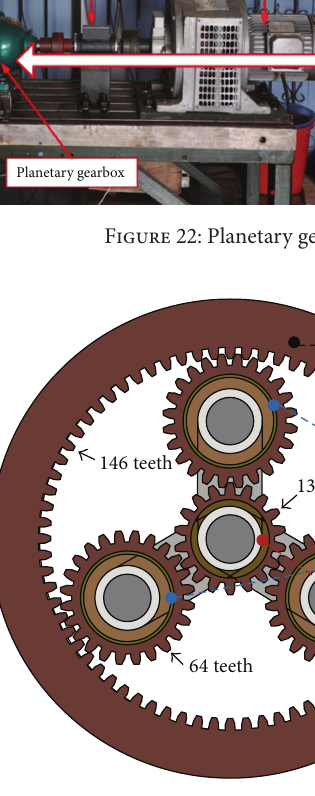
Figure 23: Schematic map of planetary gearbox structure.